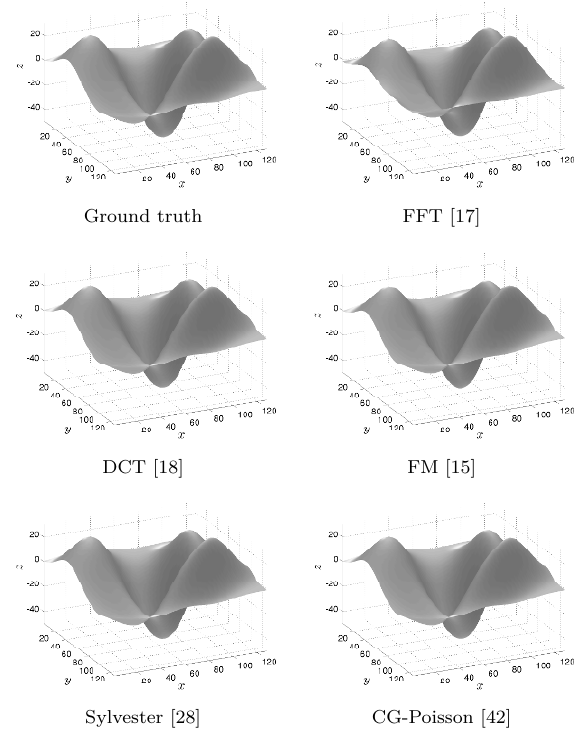
Fig. 5 Results on the “Peaks” dataset (see Table